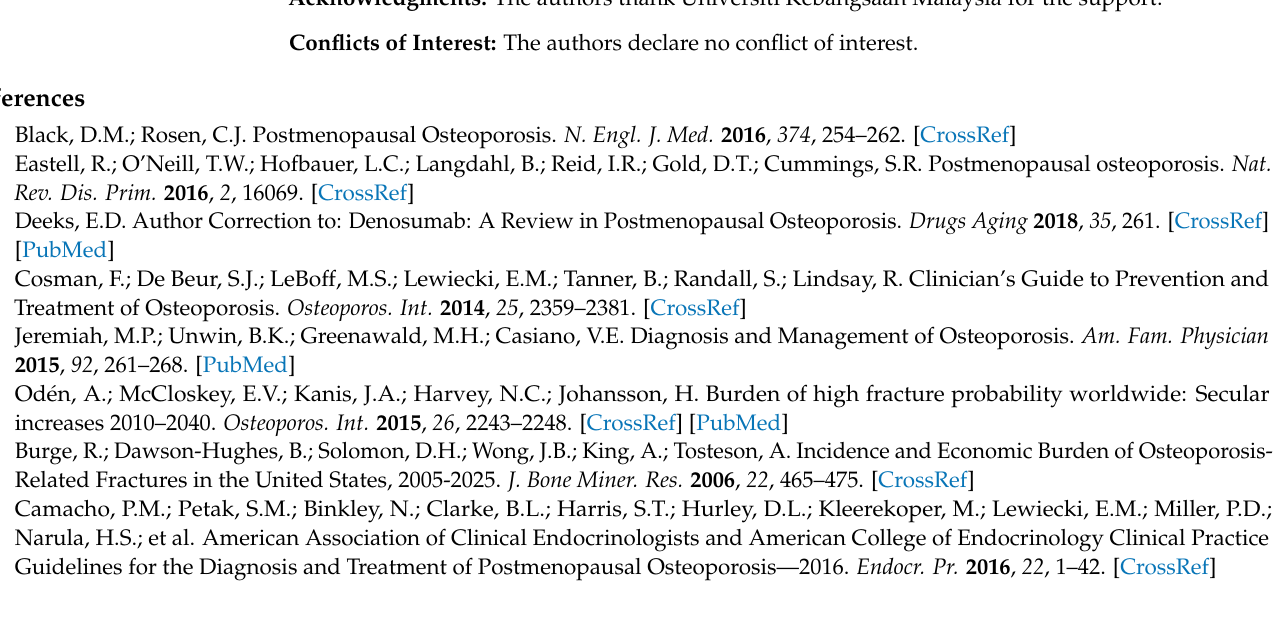
Supplementary Materials: Table S1: PRISMA Checklist, Table S2: Literature Search